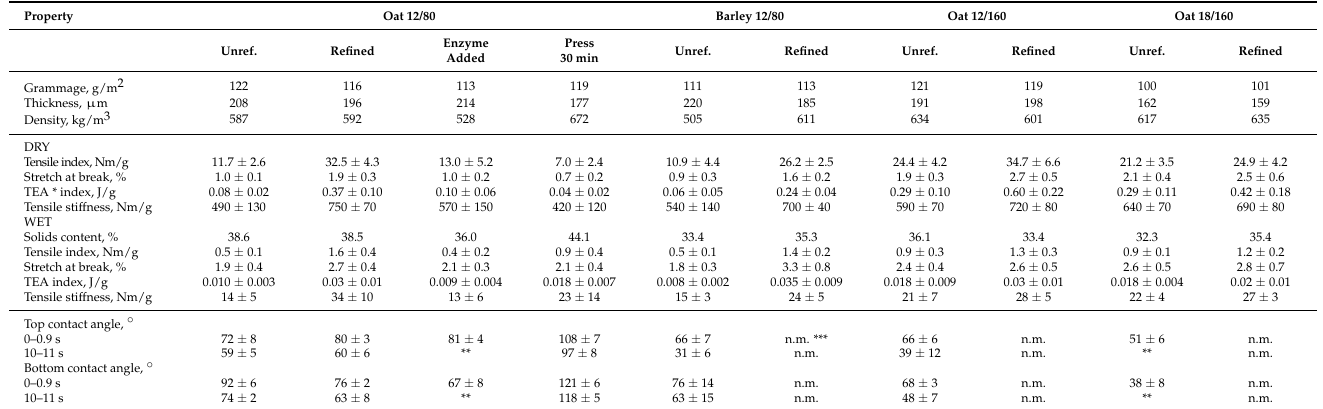
Table 4. Properties of sheets made from unrefined (unref.) and refined straw. For the refined Oat 12/80 trial point, also data with a special enzyme treatment and 30-min hot pressing are included. Wet strength was measured after 1 h of water immersion.